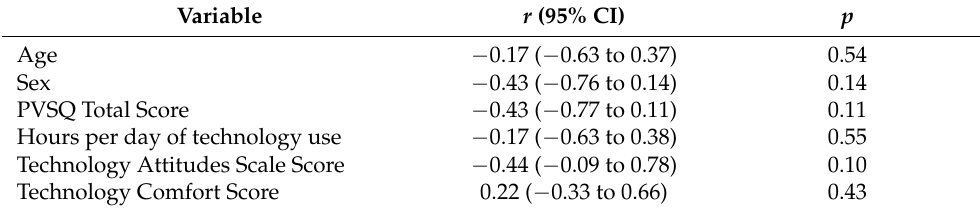
Table 4. Correlation of variables with total scores on the acceptability